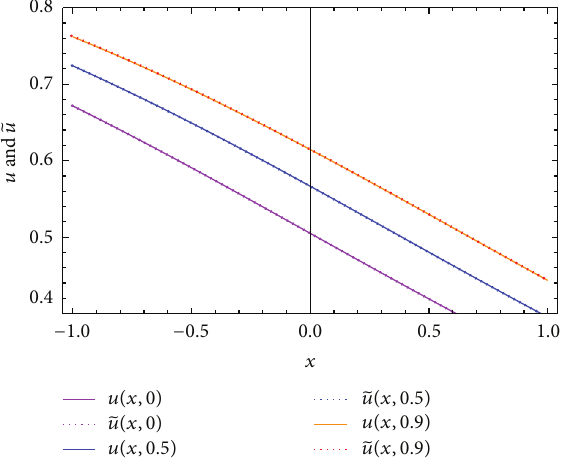
Figure 2: The curves of approximate solutions and the exact solutions of problem (32) at 𝑡 = 0.0 , 𝑡 = 0.5 , and 𝑡 = 0.9 with 𝛾 = 10 −2 and 𝑁 = 20